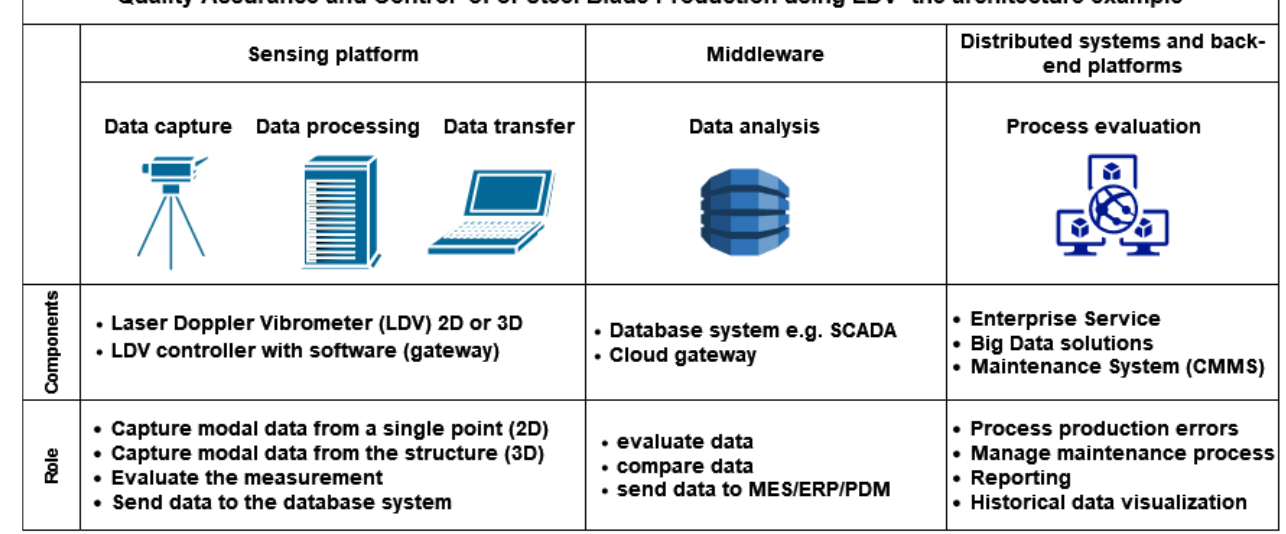
Figure 9. The proposed approach to QA and QC with 3D LDV.